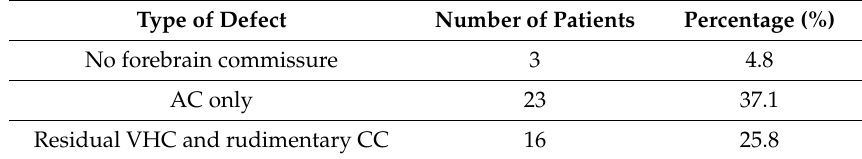
Table 4. Summary of commissural defects in the patient population